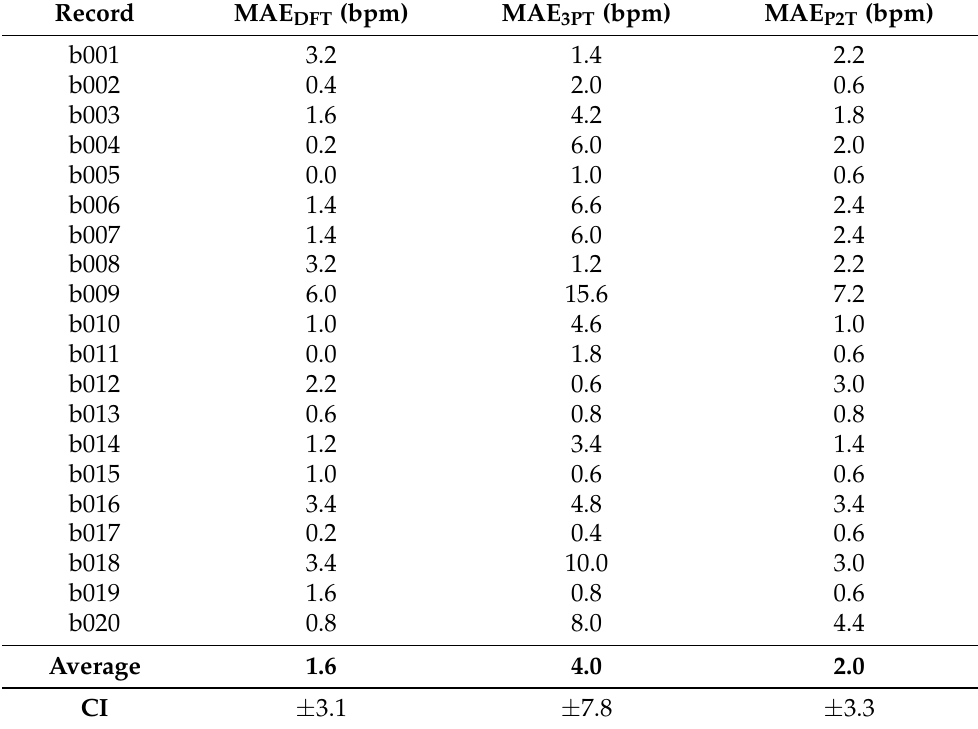
Table 3. S2 Intensity